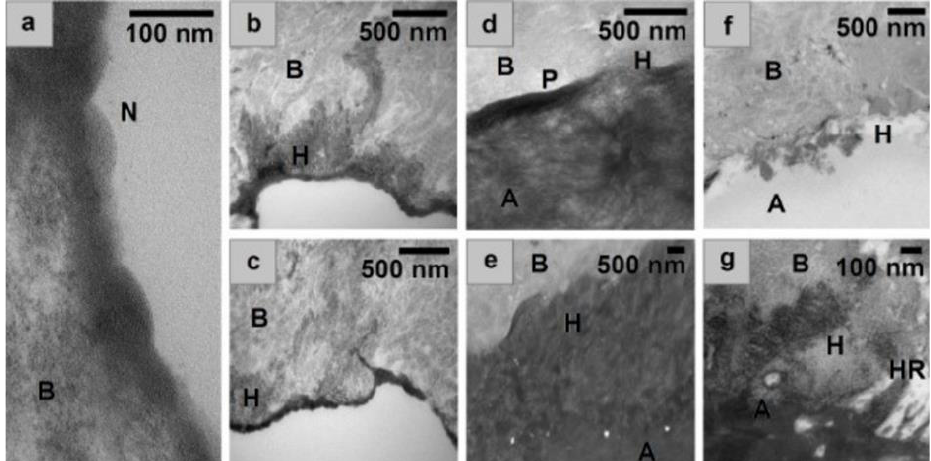
Figure 3. ( a ) nanolayering exhibited in the surface of the bone by the MDP primer, ( b , c ) MDP primer, showing integration of primer into the collagen network of the bone. Spacing of layers is equal to ~3.5 nm, ( d ) MDP + U + P, ( e ) MDP, ( f ) MDP + U, ( g ) expansion of e to showing integration, with a resin tag in d, as adhesive penetrates an open pore. B = Underlying bone demineralised during TEM processing, H = Hybrid layer N = Nanolayering, HR = Phenomenon similar to hybrid resin tag, P = Primer layer, A =